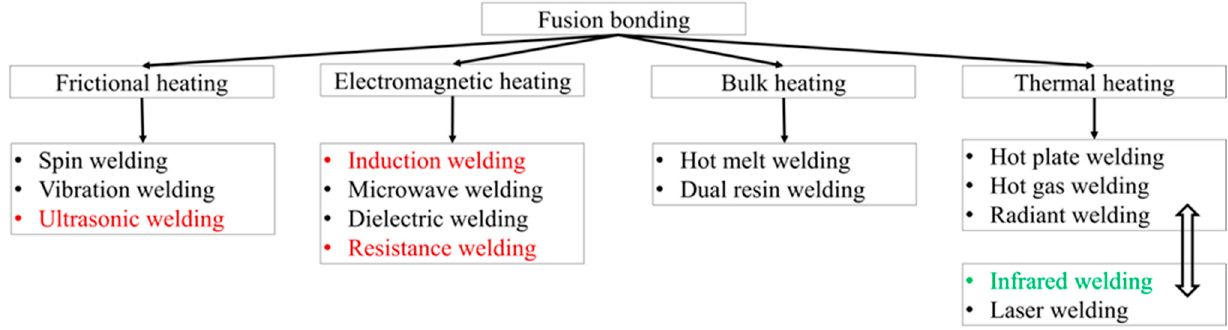
Figure 1. Variants of fusion-bonding methods for thermoplastic composites (adopted with permission from [5]. 2001, Elsevier). Table 1. Important welding factors for fusion welding processes.